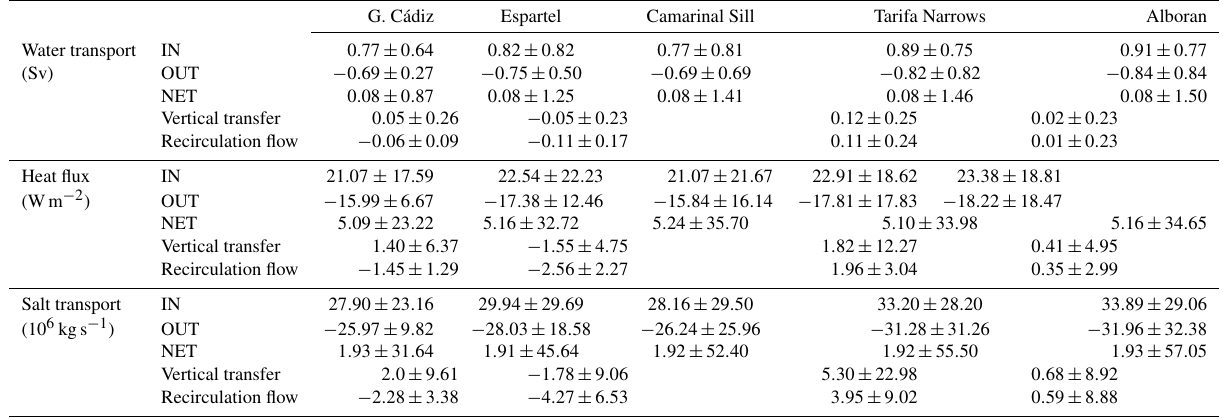
Table 4. Mean values and standard deviations of the horizontal transports of water, heat and salt computed from the tidal run at each cross- strait section. The estimated vertical transfer and recirculation fluxes between sections are also indicated. The results are shown for the 3-hourly data. Values at the outer sections already reported in Table 1 are included here for completeness.